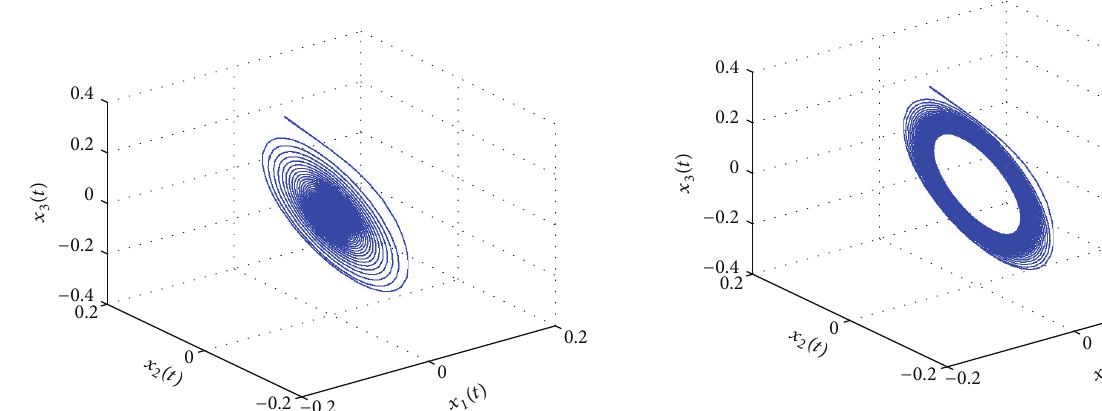
Figure 14: The phase plot of 𝑥 1 , 𝑥 2 , and 𝑥 3 when 𝜏 2 = 1.65 < 𝜏 ∗ = 0.35 . 1.7488 = 𝜏 ∗ 2 and 1